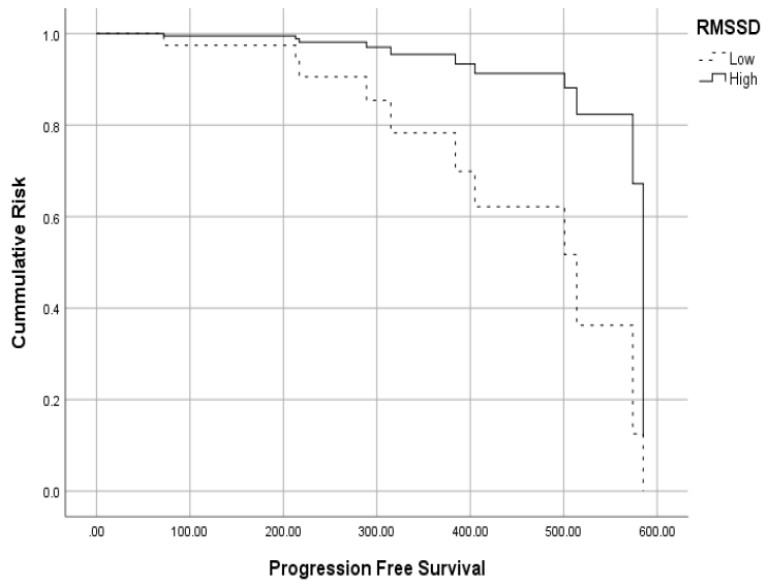
Figure 2. The relationship between HRV and PFS in MM sample. Table 4. Multivariate Cox regression between all significant bivariate predictors and